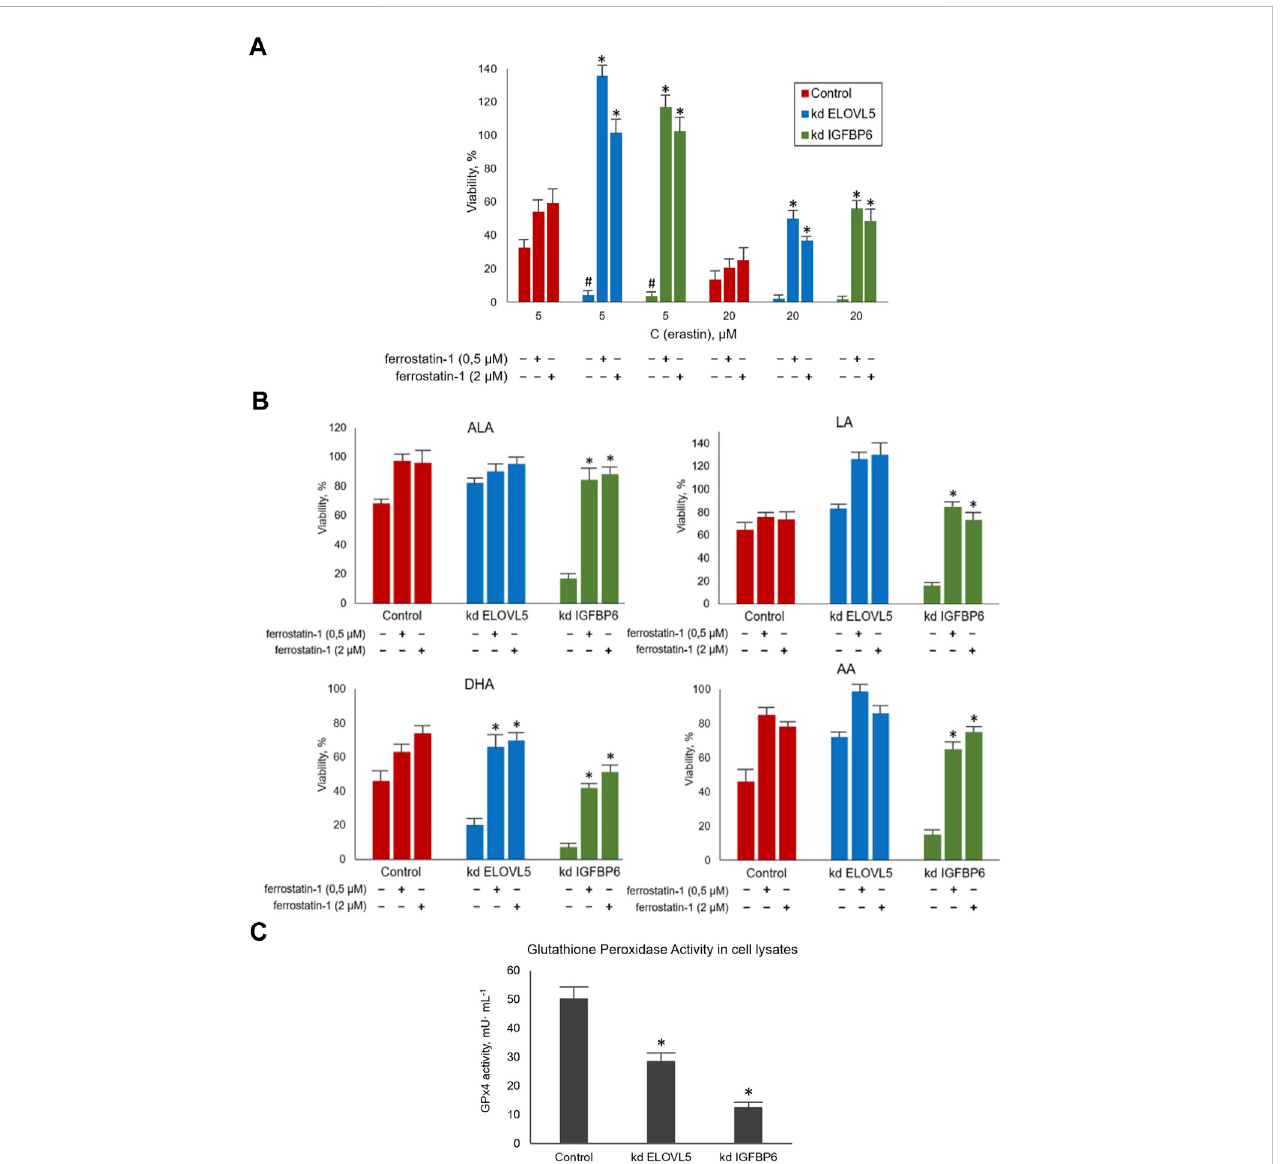
FIGURE 5 (A) Evaluation of the sensitivity of MDA-MB-231 cells to ferroptosis during their treatment with standard agents Erastin and Ferrostatin-1 in various combinationsfor24 h.Errorbarsrepresentstandarderrorofmean(SEM, n =3).* — p < 0.05versuspureErastin.# — p < 0.05versuscontrolcells. (B) Evaluation of the sensitivity of MDA-MB-231 cells to ferroptosis during their treatment with LC-PUFA and Ferrostatin-1 for 24 h. The concentration for LA, AA, and ALA was 300 μ M and for DHA 200 μ M. Error bars represent standard error of mean (SEM, n = 3). * — p < 0.05 versus pure PUFA. (C) Glutathione Peroxidase Activity measured in cell lysates per one million cells after 10 min of incubation. Error bars represent standard error of mean (SEM, n = 3). * — p < 0.05 versus control